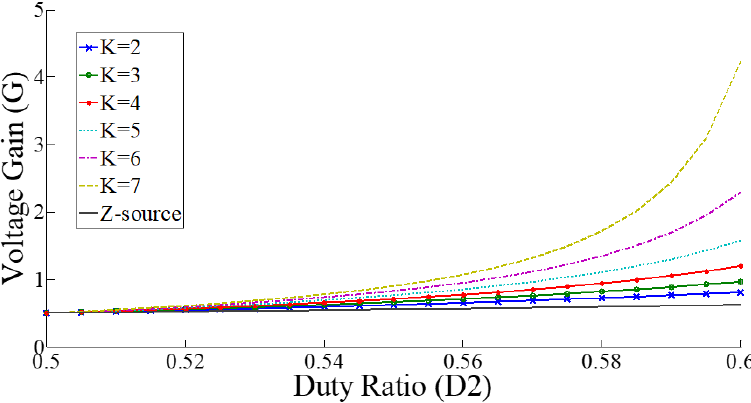
Figure 5. The relationship between the voltage gain and duty cycle: winding